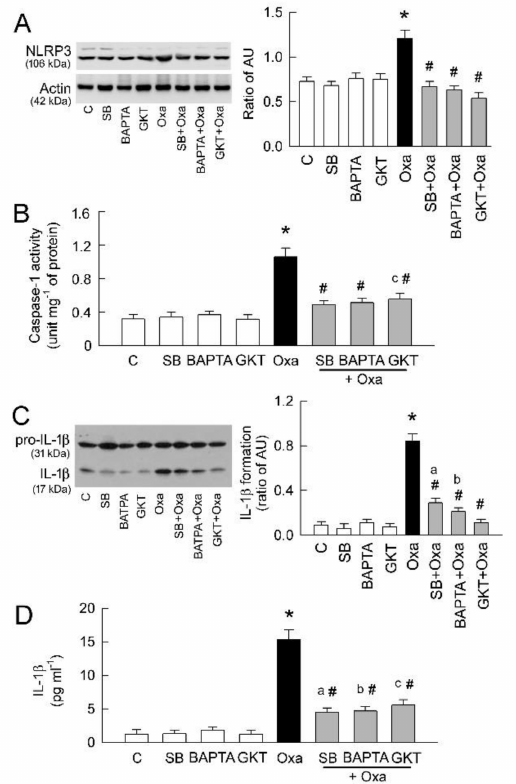
Figure 4. Inhibition of TRPV1 atteuates oxalate-mediated inflammatory response in tubular cells. ( A ) Representative blots are shown for NLRP3 expression using 10 µ g of total protein in each group. Right bar graph shows densitometrically quantified results by ratio of NLRP3 to actin (n = 6 per group). AU, abritary unit of band density. Note that TRPV 1 blocker SB, Ca 2+ chelator BPATA, and Nox inhibitor GKT totally abrogate NLRP3 upregulation caused by oxalate (Oxa). ( B ) Bar graph showing